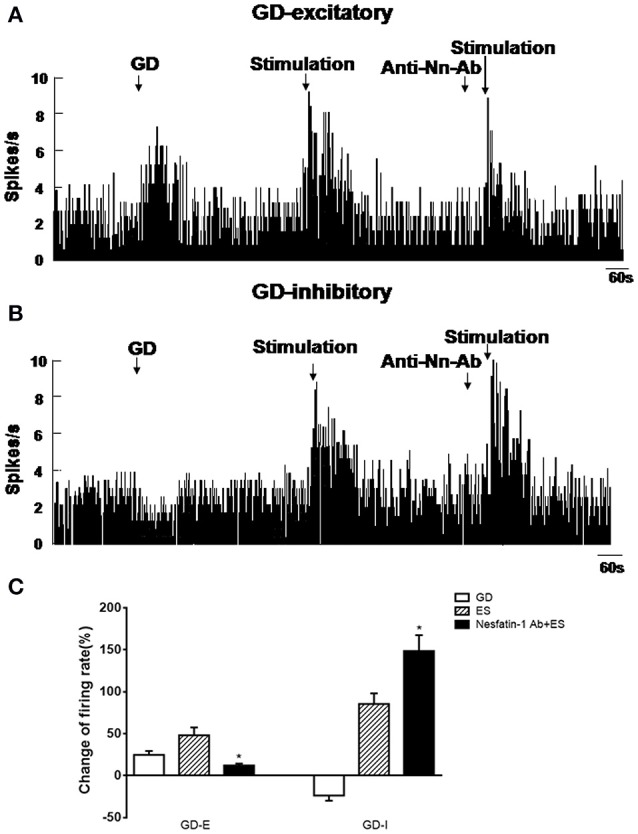
Effect of NAc electrical stimulation on the firing rate of GD-responsive neurons in the VMH (n = 80). (A) GD-E neurons in the VMH were mostly excited by NAc electrical stimulation, (B) GD-I neurons in the VMH were mostly excited by NAc electrical stimulation. (C) Shows the change in firing rate (%) of GD-responsive neurons in the VMH induced by NAc electrical stimulation. Pre-treatment with NUCB2/nesfatin-1 antibody in the VMH reduced the effect of NAc electrical stimulation on VMH GD-responsive neurons. *P < 0.05 vs. electrical stimulation.